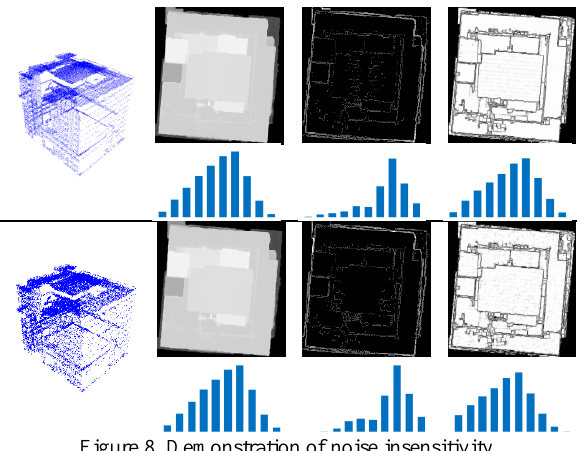
Figure 8. Demonstration of noise insensitivity.